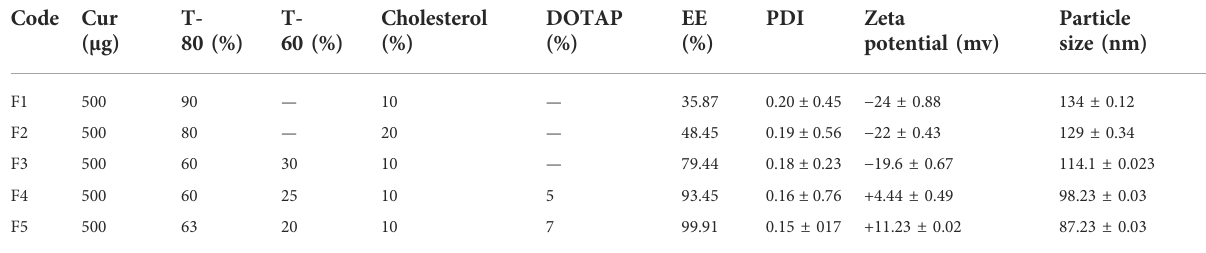
TABLE 1 The effect(s) of T-80:T-60:cholesterol ratio on the EE%, PDI, zeta potential (mV), and particle size (nm) in Cur-niosome particles. Code Cur (µg)